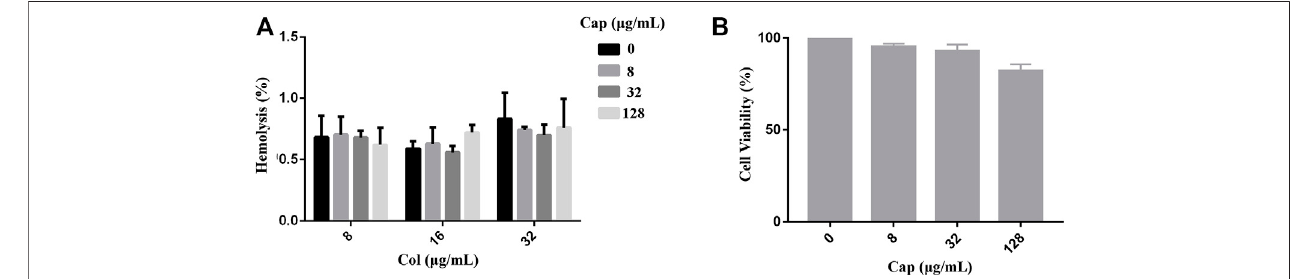
FIGURE 2 | Safety assessment of capsaicin. (A) : Hemolytic activity of capsaicin (8 – 128 μ g/mL) in the absence or presence of colistin (8 – 32 μ g/mL) to the RBCs. (B) : In vitro mammalian toxicity in A549 cell lines. The data shown here are mean ± SD of three replicates.